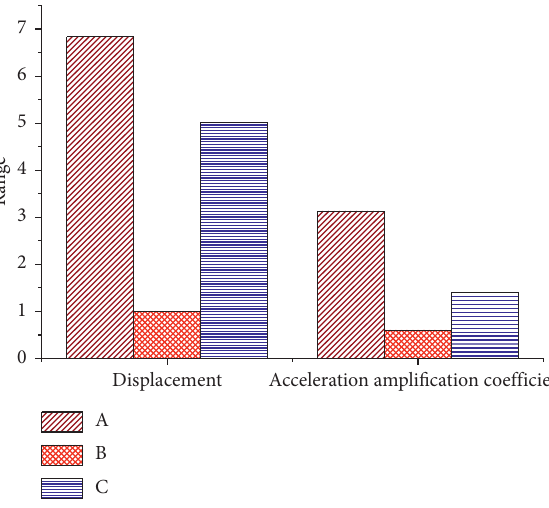
Figure 13: Comparison of range of different test